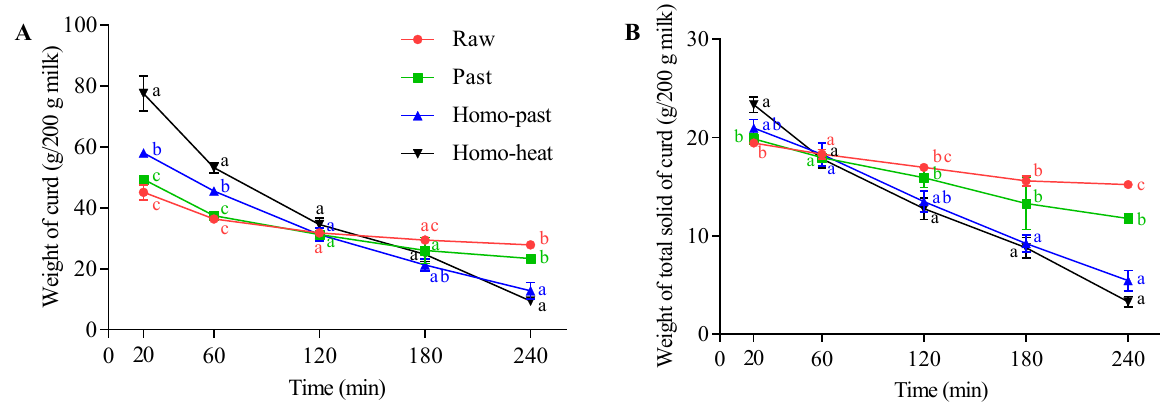
Figure 4. Changes in ( A ) the weight of the curds and ( B ) the weight of the total solids of the curds at different time points (20–240 min) during the in vitro gastric digestion of differently processed sheep milks: ● , raw milk; ■ , pasteurized (Past) milk; ▲ , homogenized and pasteurized (Homo–past) milk; ▼ , homogenized and heated (Homo–heat) milk. Different lowercase letters indicate significant difference ( p < 0.05). Error bars represent standard deviations.